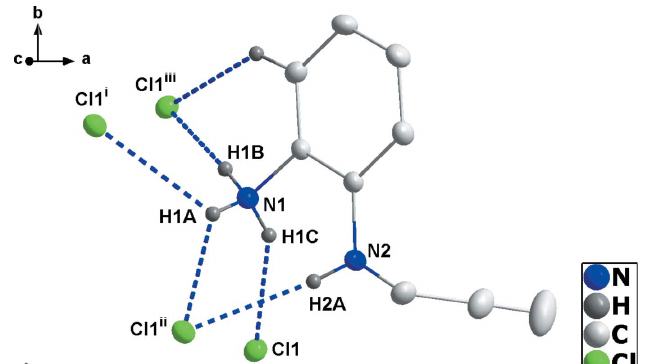
Figure 2 Details of the cation–anion interactions, with hydrogen bonds shown as dashed lines and symmetry operations as in Table 1.